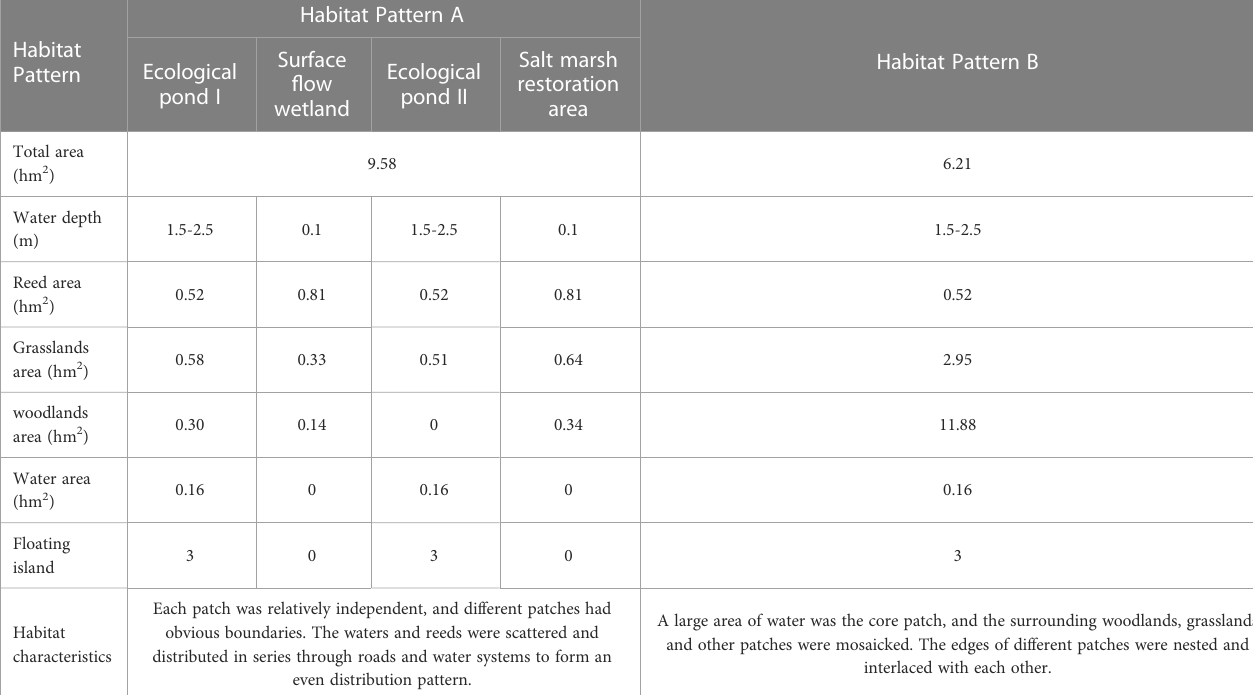
Habitat Pattern